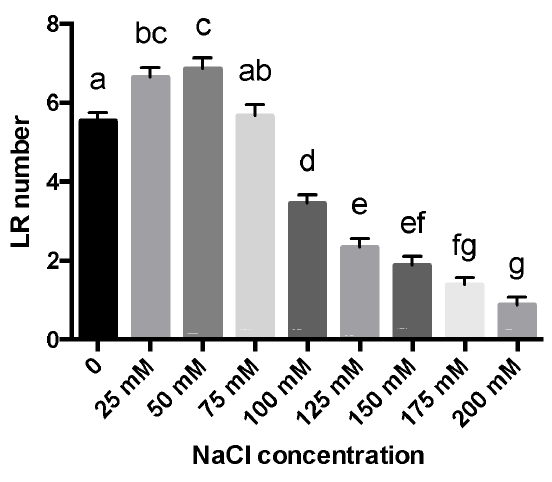
Figure 1. Number of lateral roots in response to salt stress. S. lycopersicum seedlings were treated with increasing concentrations of NaCl (0, 25, 50, 75, 100, 125, 150, 175, and 200 mM). The lateral root number (LR number) was measured after 10 days of NaCl treatment. The letters a–g represent statistically significant differences with p < 0.05. Error bars represent the standard error of the